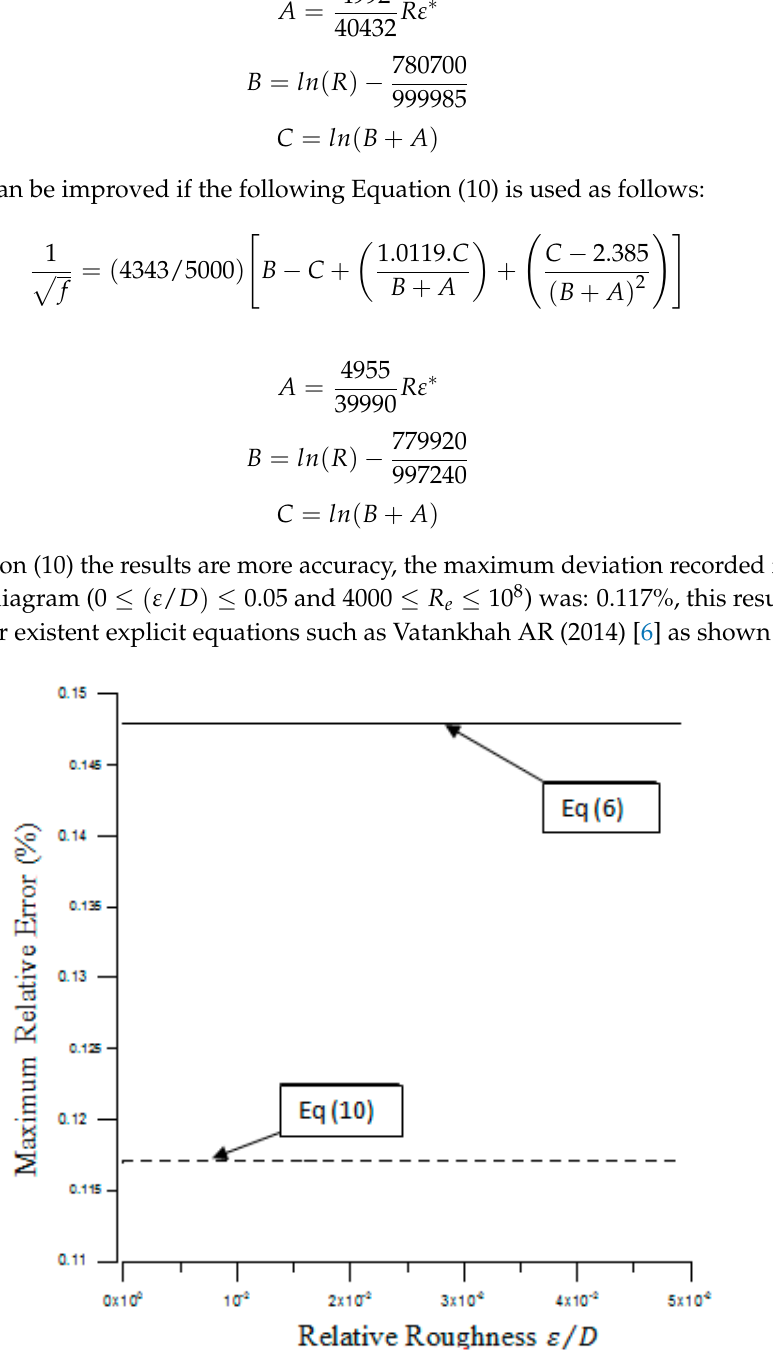
Figure 5. The maximum deviation (in percent) for versus different relative roughness. Values of the improved Equations: 6 and 10.